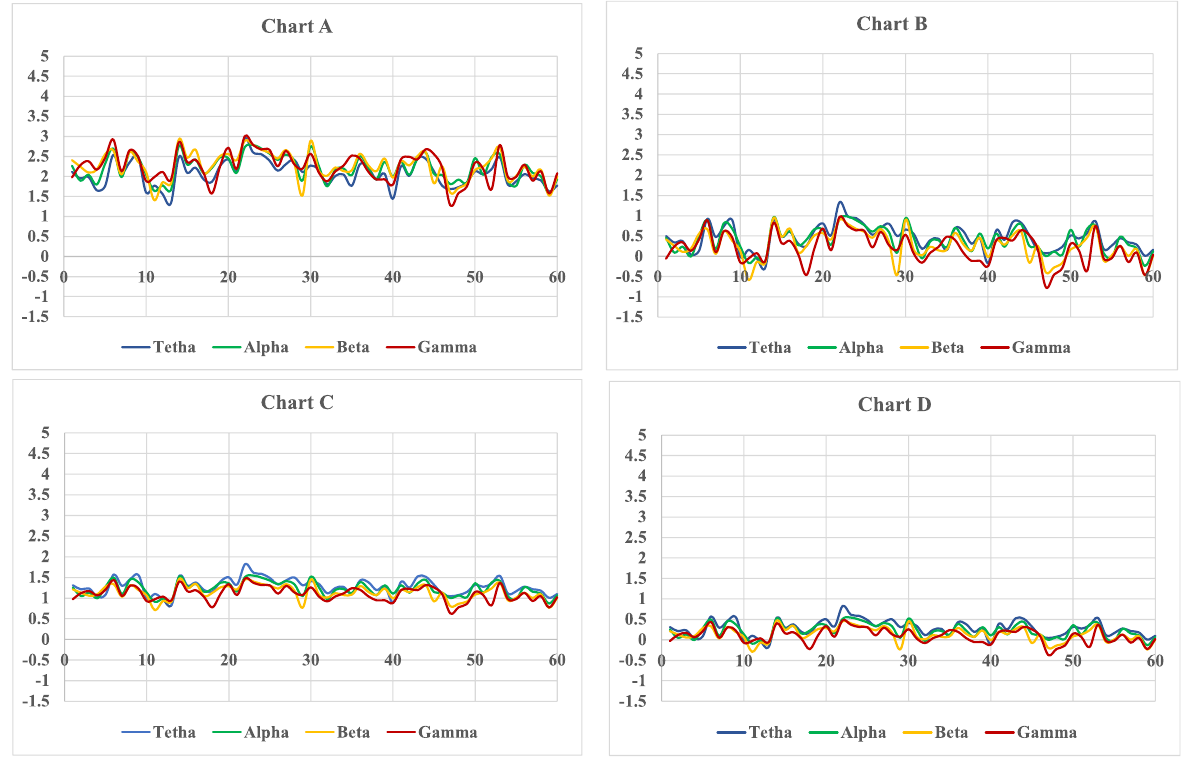
Figure 10. Visualization of experiment EEG signals before and after baseline reduction. (Graph A) Before baseline reduction. (Graph B) After baseline reduction using the Difference method. (Graph C) After baseline reduction using the Relative Difference method. (Chart D) After baseline reduction using the Fraction